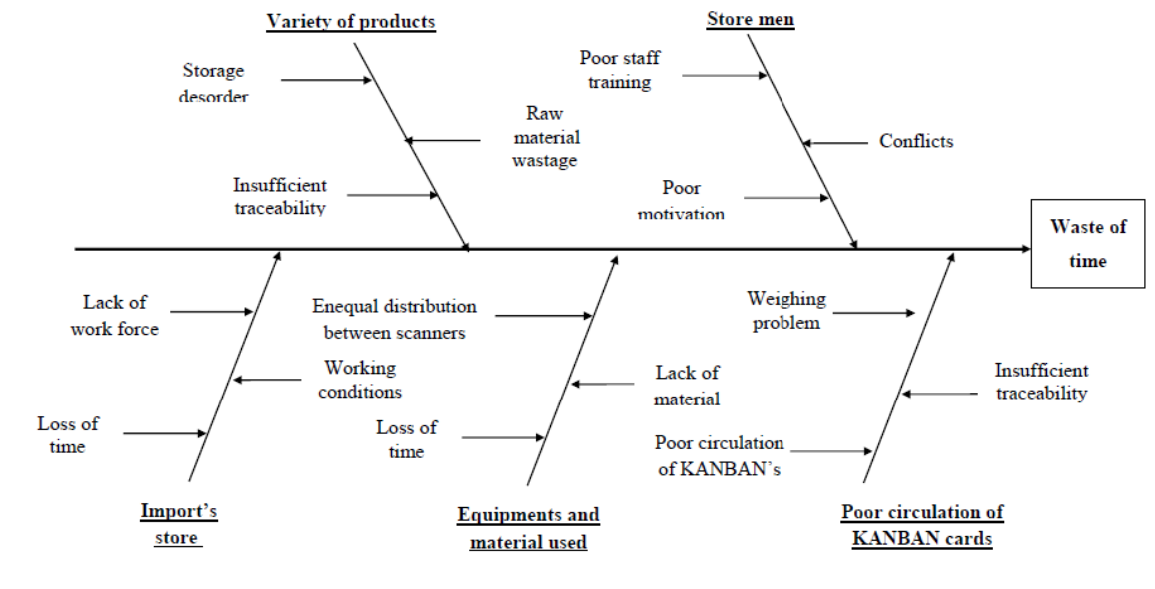
Figure. 3: Causes and effect diagram of the import’s store of LEONI